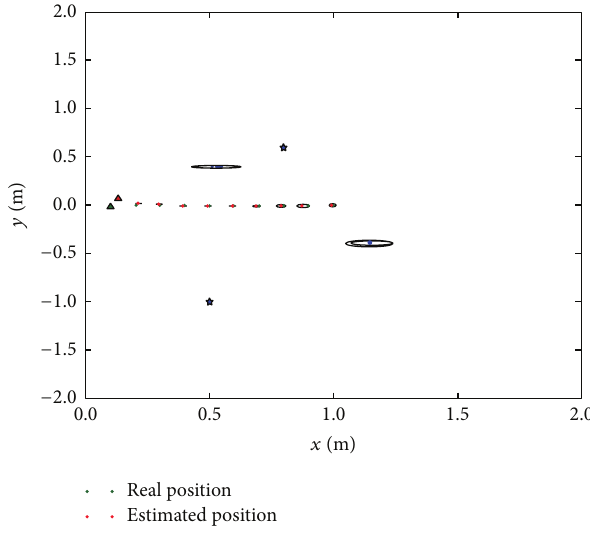
Figure 10: The experiment motion result of Robot SLAM with closed-loop controller.